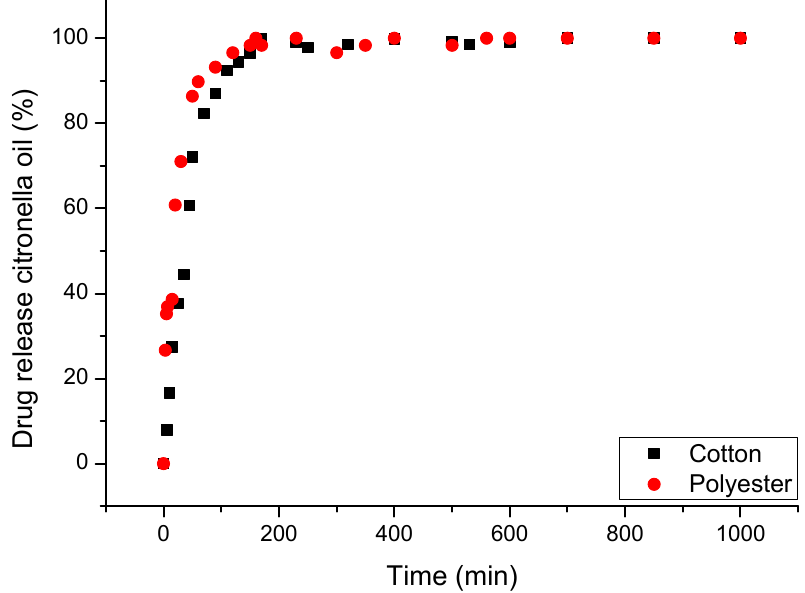
Figure 5. In vitro controlled release profiles in water at 37 °C for microencapsulated citronella oil applied on textiles.